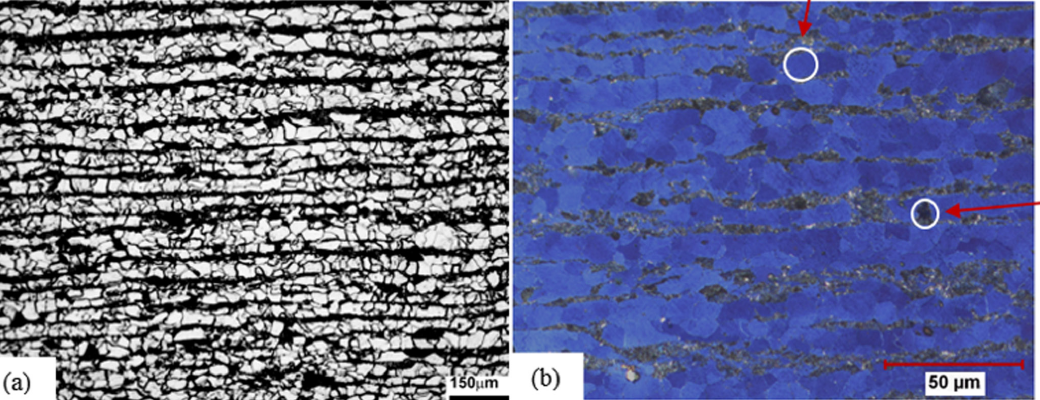
Figure 3: Optical microstructure characterization of base metal. (a) 2% Nital etching and (b) Klemm I